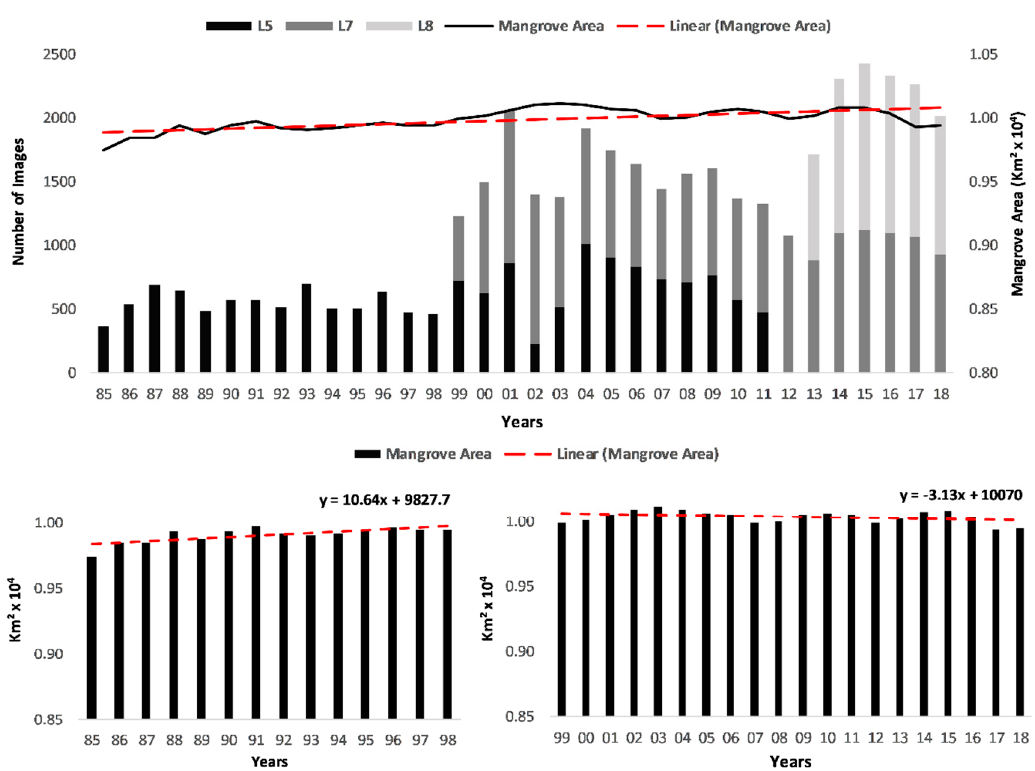
Figure 8. The top image shows the general pattern of fluctuation in the mangrove areas from 1985 to 2018. The solid line represents the variation in mangrove area over time. The dotted line shows the general trend. The bars show the distribution of Landsat images along the time series. L5 stands for Landsat-5, L7 refers to Landsat-7 and L8 stands for Landsat-8. The bottom left image shows the mangrove area variation and trend line from 1985 to 1998. The bottom right image shows the mangrove areas and trends from 1999 to 2018.